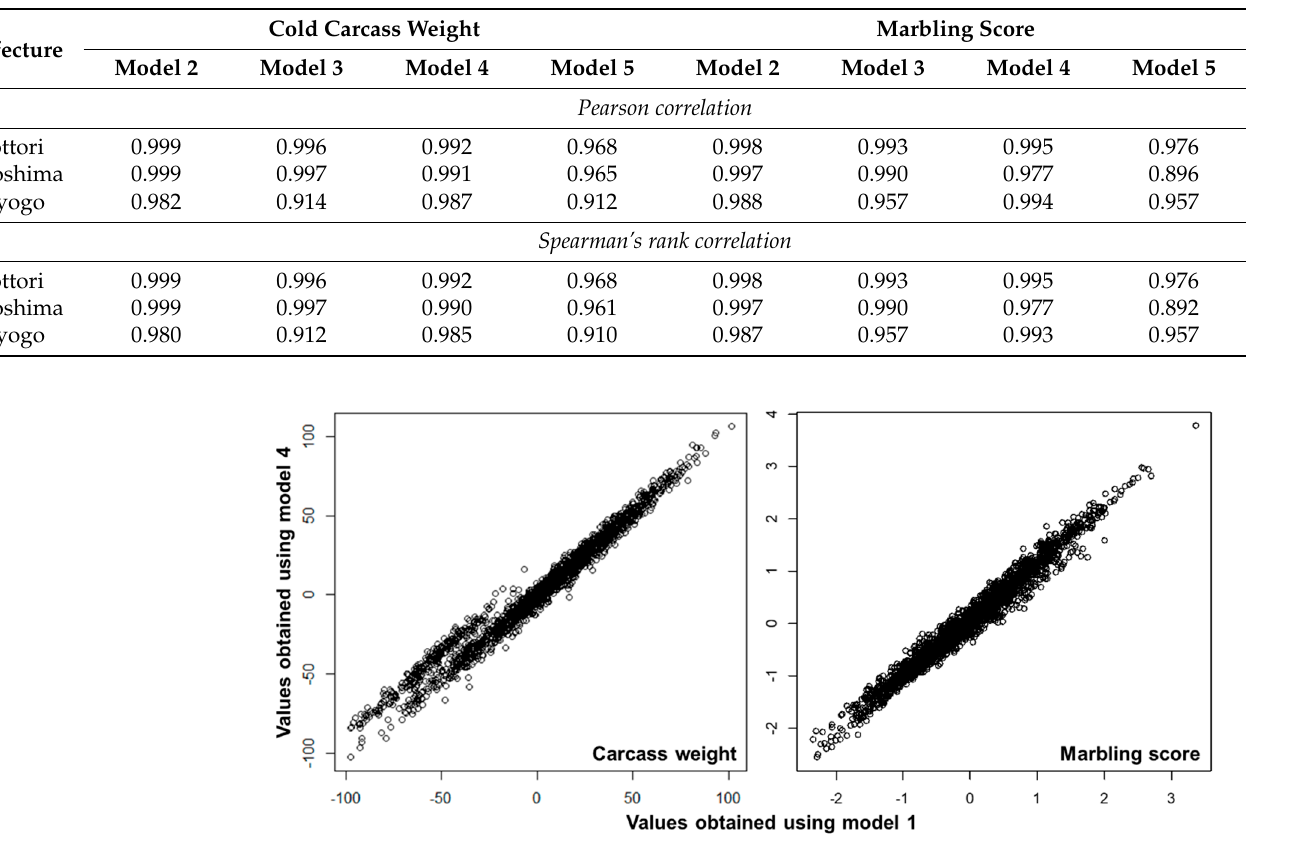
Figure 3. Scatter plots of predicted genomic breeding values obtained using models 1 and 4. Table 5. Means and standard deviations (SDs) of predicted genomic breeding values for the steers marketed into each prefecture 1 .